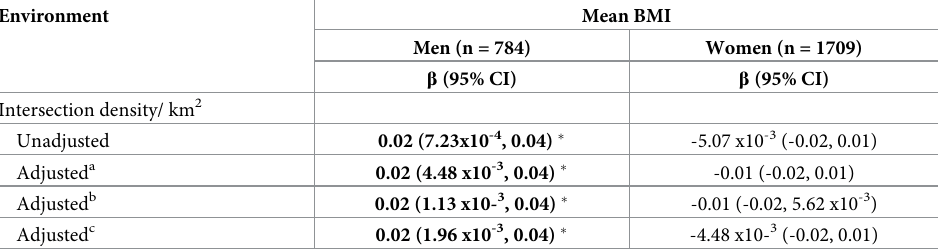
Table 3. Sex-specific unadjusted and adjusted β coefficients (Confidence Intervals in brackets) for the association of intersection density/km 2 with mean Body Mass